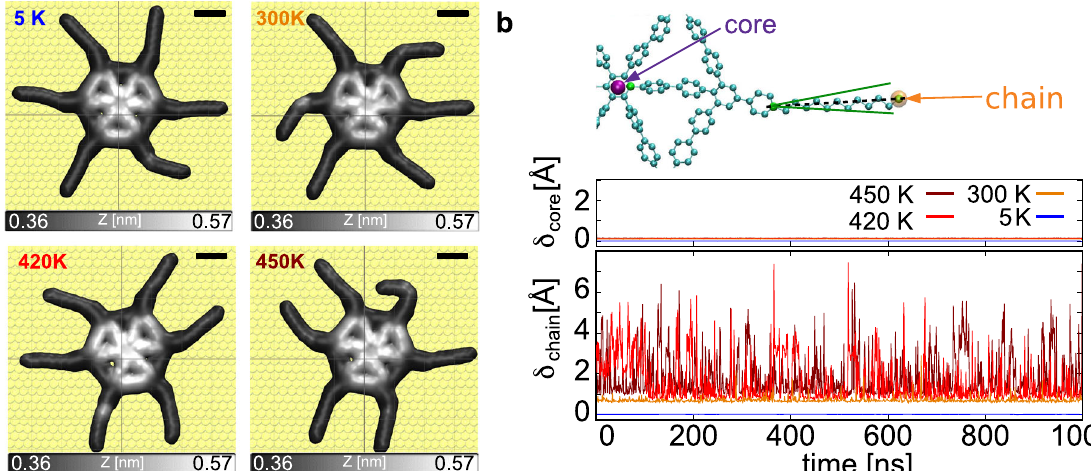
Fig. 3 Temperature dependence of the SW core versus chains based on MD simulations. a Final positions and con fi gurations of single SW molecules after 1 μ s at different temperatures. b Schematic illustration of representative positions of the molecules (top). Standard deviation of the mean square displacement (MSD) - δ - of the SW centre of mass as a function of time for different temperatures (middle). Standard deviation of the MSD - δ chain - of core a SW chain as a function of time for different temperatures (bottom). The MSD itself (shown in Supplementary Fig. 6) and its standard deviation are obtained through a running time average of 1